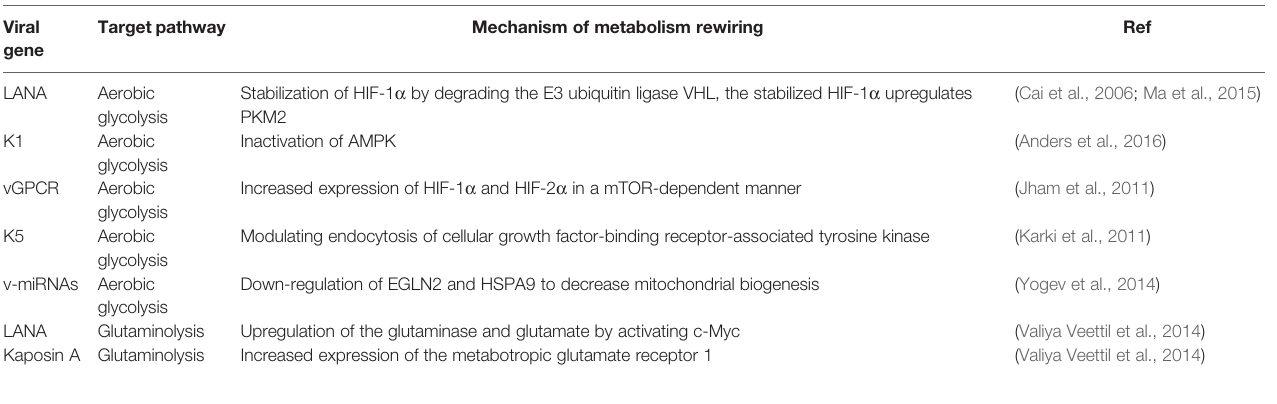
TABLE 1 | List of KSHV-encoded proteins reprogramming host metabolism. Viral Target gene